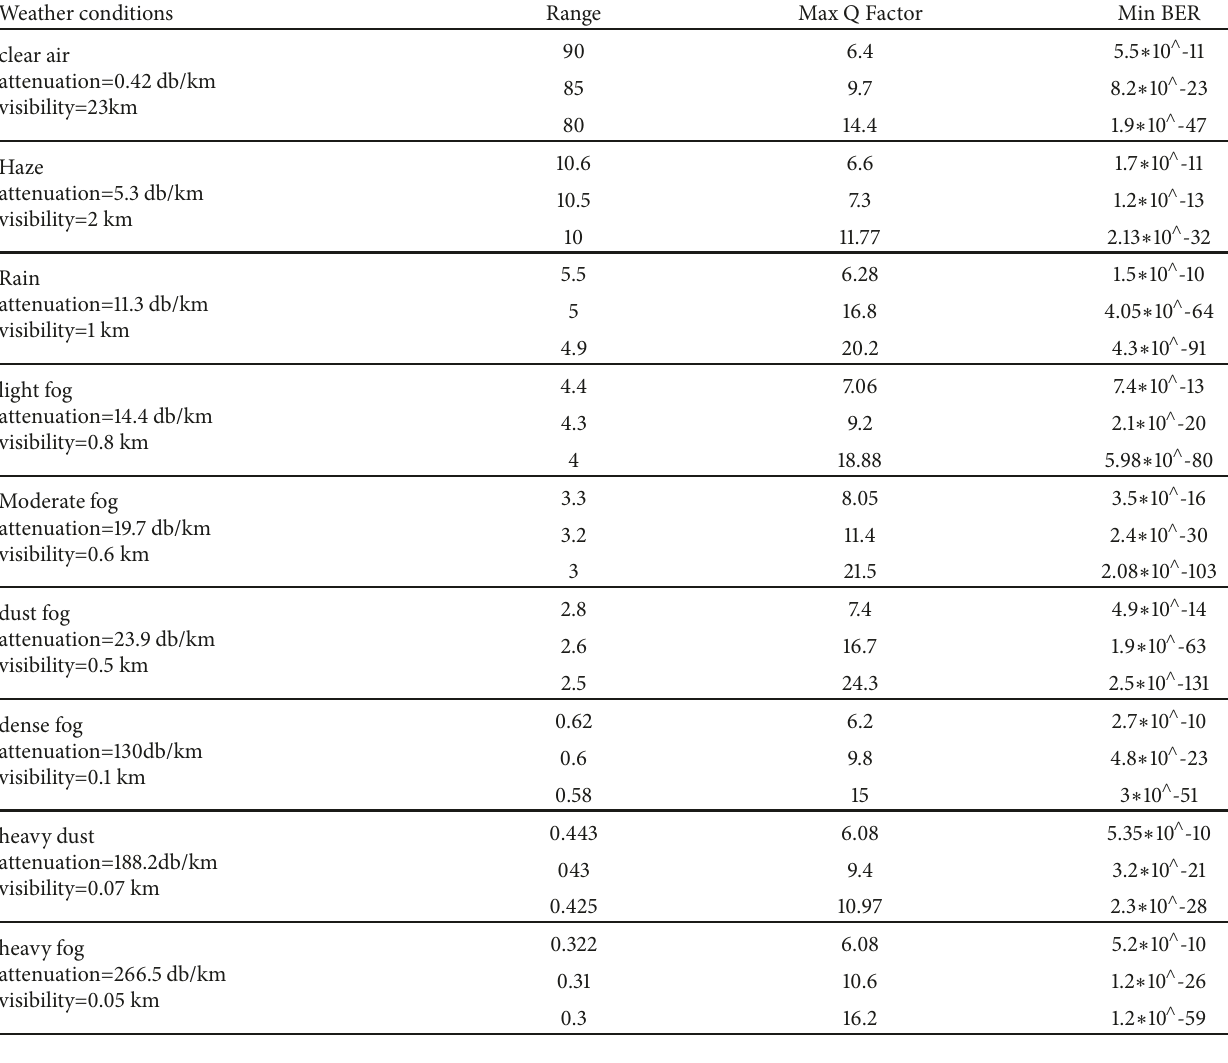
Table 7: Results for 2T X /2R X FSO at different weather conditions for 850 nm wavelength.